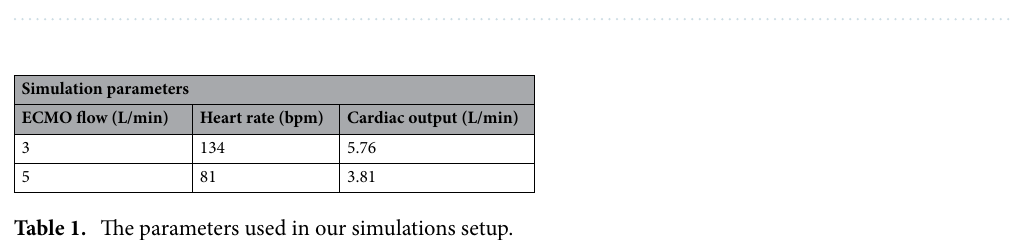
Figure 1. CT-segmented geometry for two configurations. Reconstructed patient anatomy with two different position configurations of the draining and returning cannula. Left: both cannulae are placed at the entrance to the right atrium; this configuration is labelled ( 0, 0 ) . Right: The draining cannula is located at 2 cm from the atrium entrance, while the returning cannula is located at 3 cm from the entrance; this configuration is labelled ( 2, 3 ) .